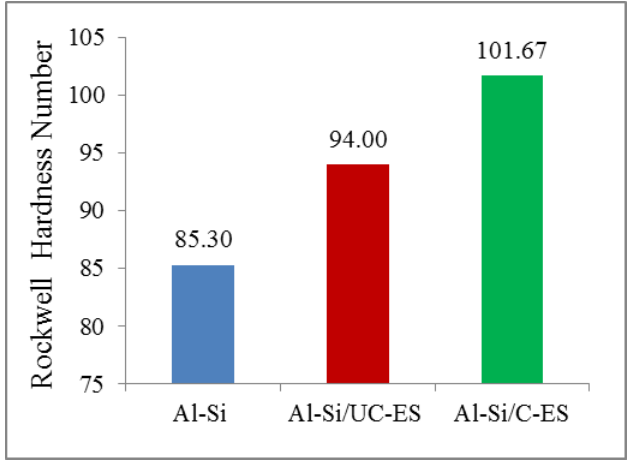
Fig. 7. Variation hardness of control sample and the two